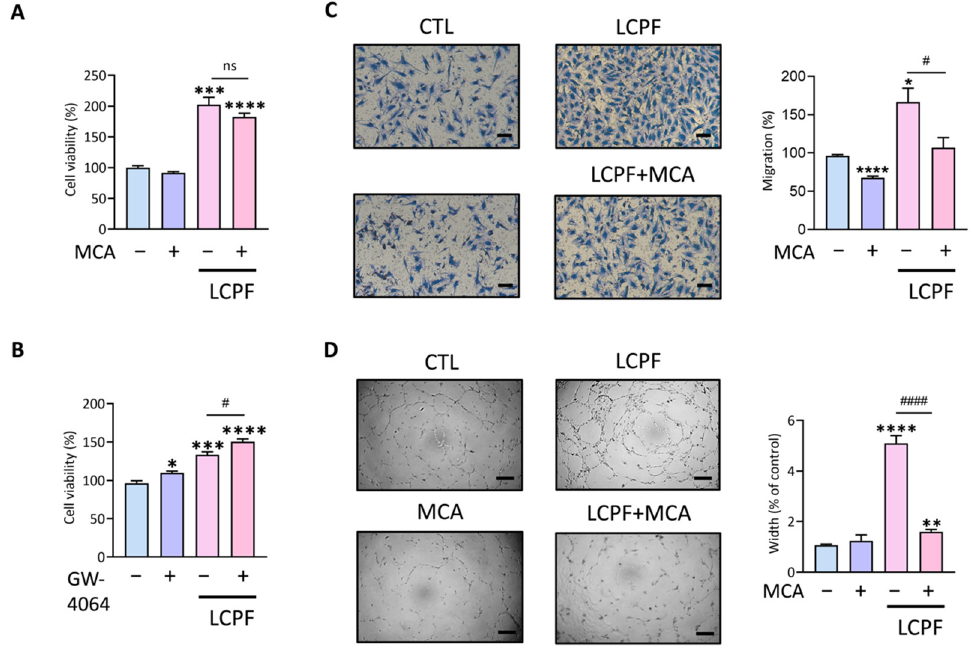
Figure 3. β -Muricholic acid as an FXR antagonist alleviated LCPF-induced endothelial motility and angiogenesis. β -Muricholic acid (MCA) and GW4064 were applied as the FXR antagonist and agonist, respectively. HUVECs were treated with MCA (10 µ M) or GW4064 (10 µ M) in a LCPF-containing medium for 24 h. ( A , B ) Cell viability was analyzed by MTT assay after treatment. ( C ) Representative images and statistical analysis of a Transwell assay at 18 h after LCPF culture with or without 10 µ M MCA. ( D ) Micrographs and statistical analysis of tube width at 12 h after LCPF culture with or without 10 µ M MCA. Scale bar = 200 µ m. * p < 0.05; ** p < 0.01; *** p < 0.001; **** p < 0.0001, compared to the control group. # p < 0.05; #### p < 0.0001, compared to the LCPF group.